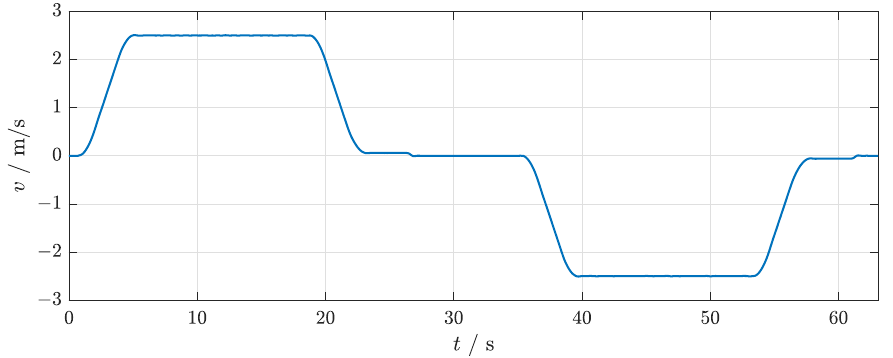
Figure 2. Example of elevator speed during the reference